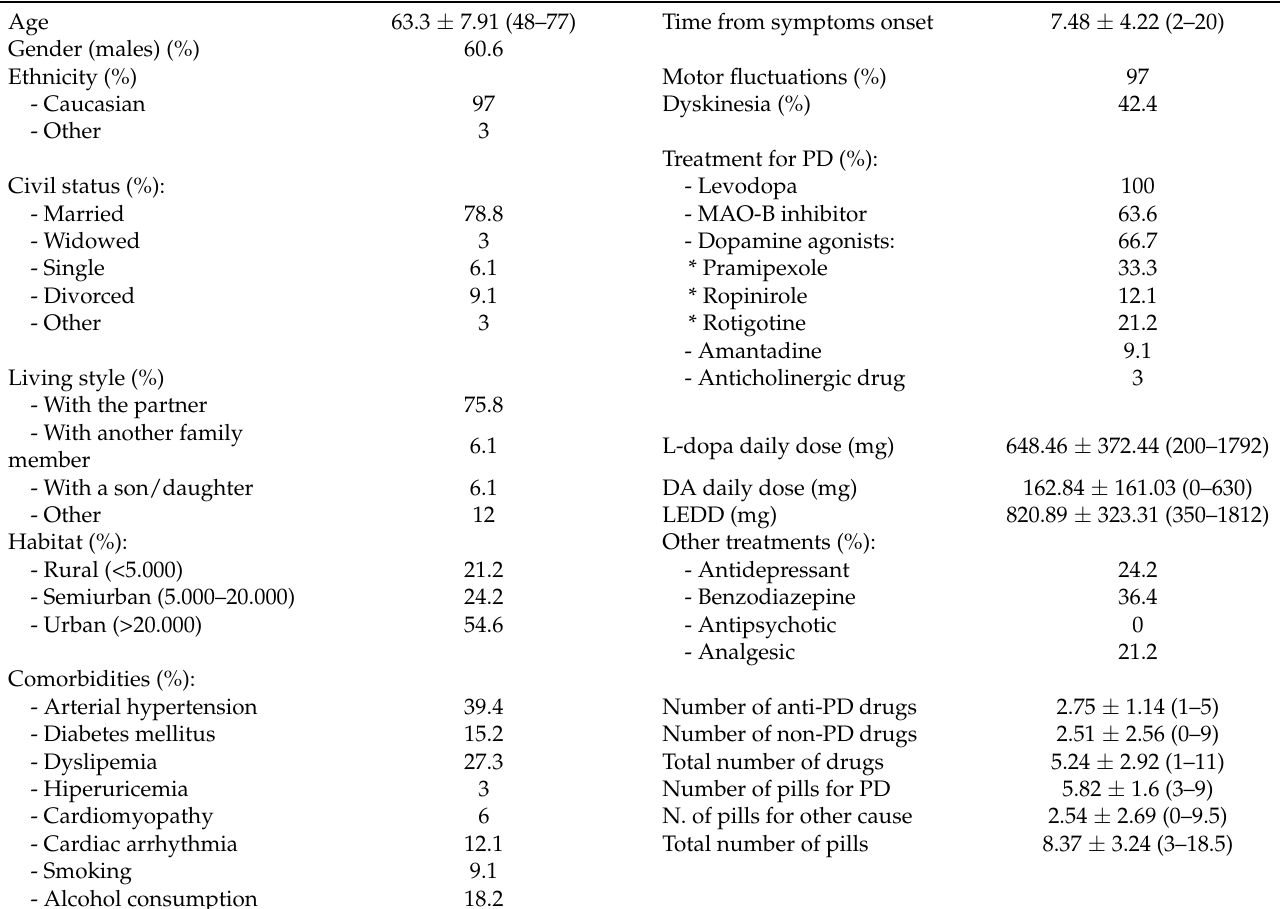
Table 1. Data about sociodemographic aspects, comorbidities, antiparkinsonian drugs, and other therapies at baseline (N =